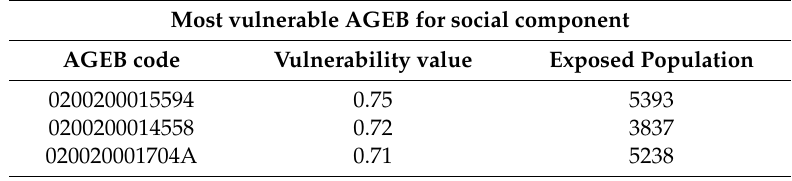
Table 4. Most vulnerable AGEB units for each component and the overall composed FVI .